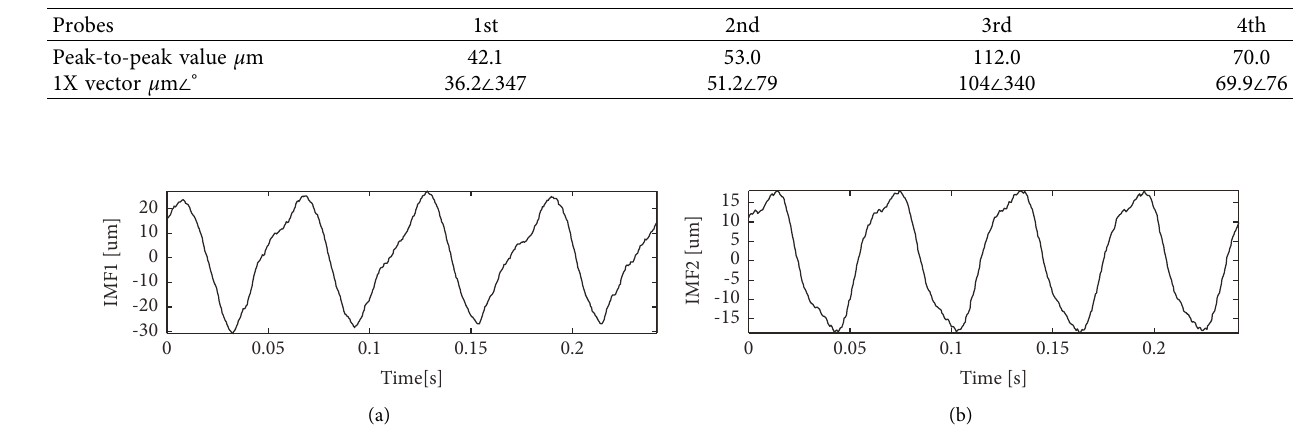
Figure 9: The original signal collected from (a) the 3# and (b) 4# sensors.